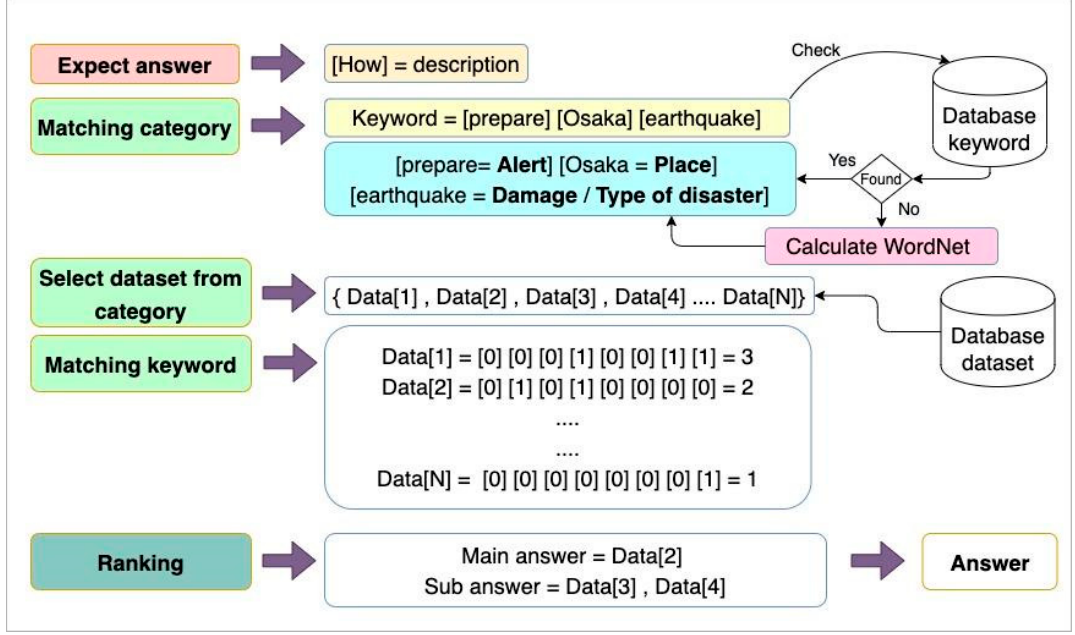
Figure 7. Answer processing phase.